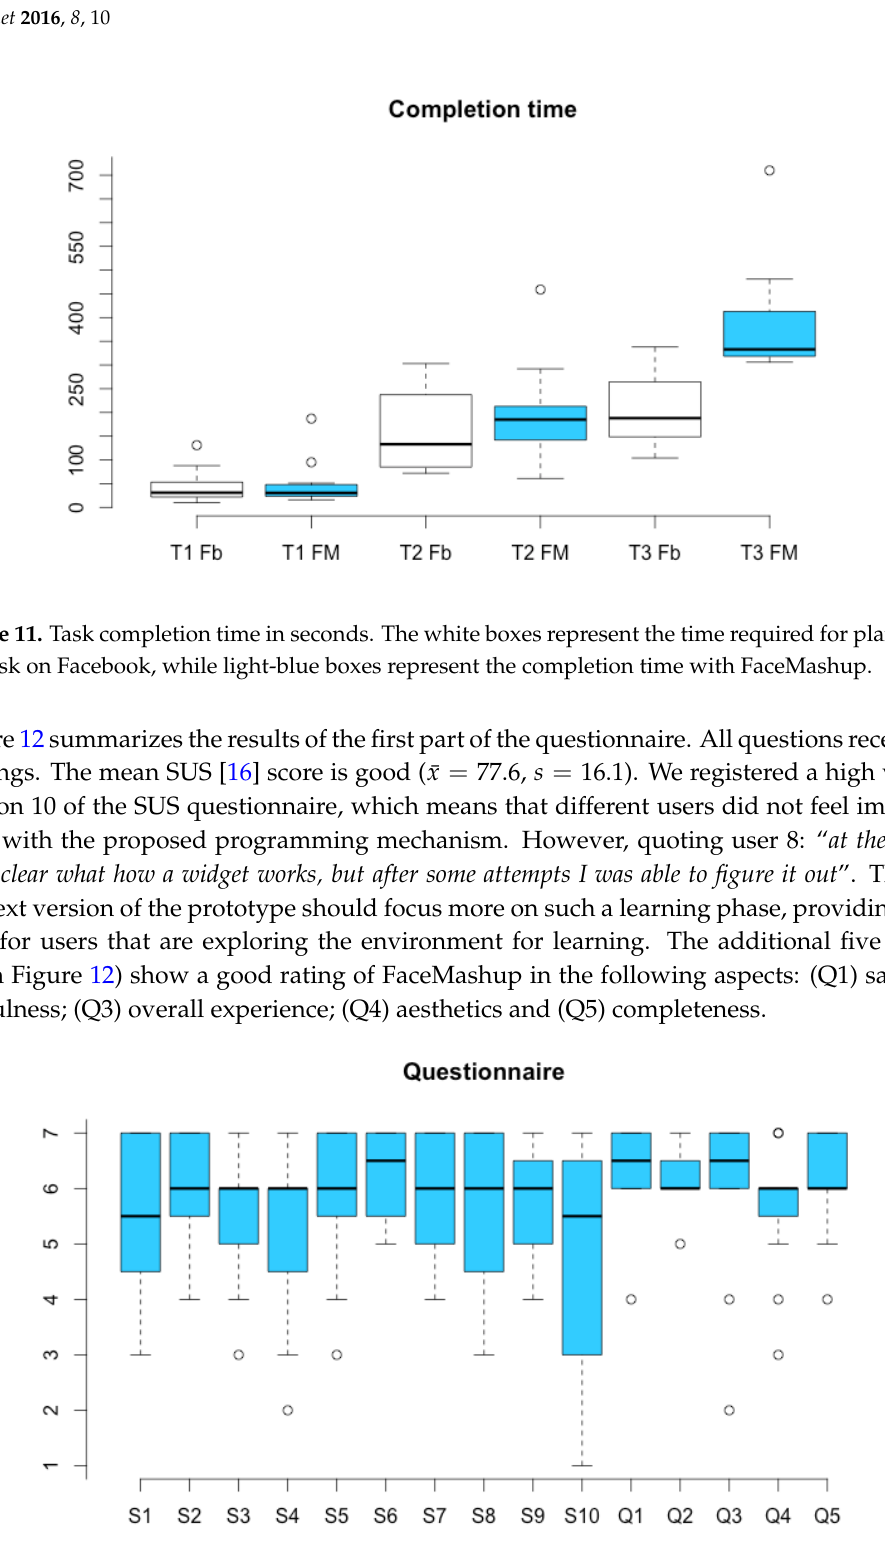
Figure 12. Evaluation questionnaire results. The ratings range from 1 (most negative) to 7 (most positive). The SUS [16] questions having a negative connotation are reported with inverted